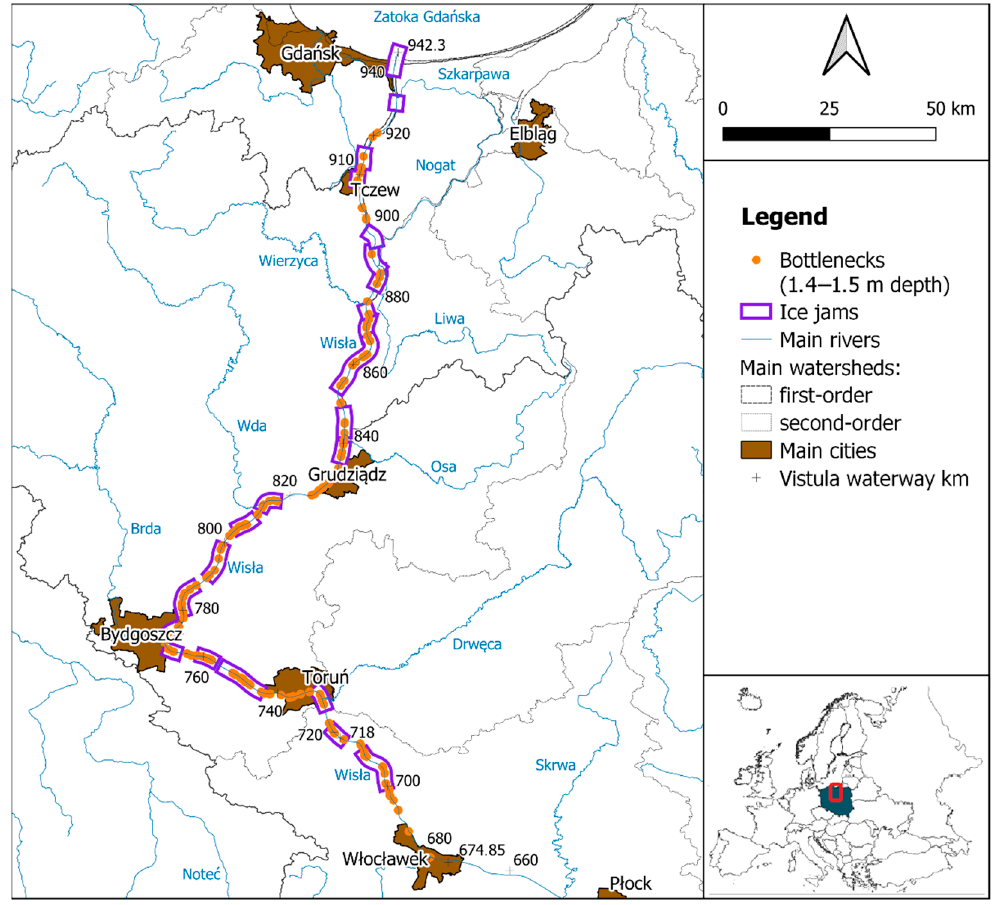
Figure 2. Designated ice jam sections on the Vistula River from W ł oc ł awek to the Gdansk Bay [21] and places with the smallest depths of 1.4–1.5 m, developed on the basis of sonar soundings from November 2021 [18] at the following water levels on water gauges: W ł oc ł awek: 163 cm, Toru ń : 185 November 2021 [18] at the following water levels on water gauges: Włocławek: 163 cm, Toru´n: cm, Fordon: 186 cm and Che ł mno: 231 cm [19]. 185 cm, Fordon: 186 cm and Chełmno: 231 cm